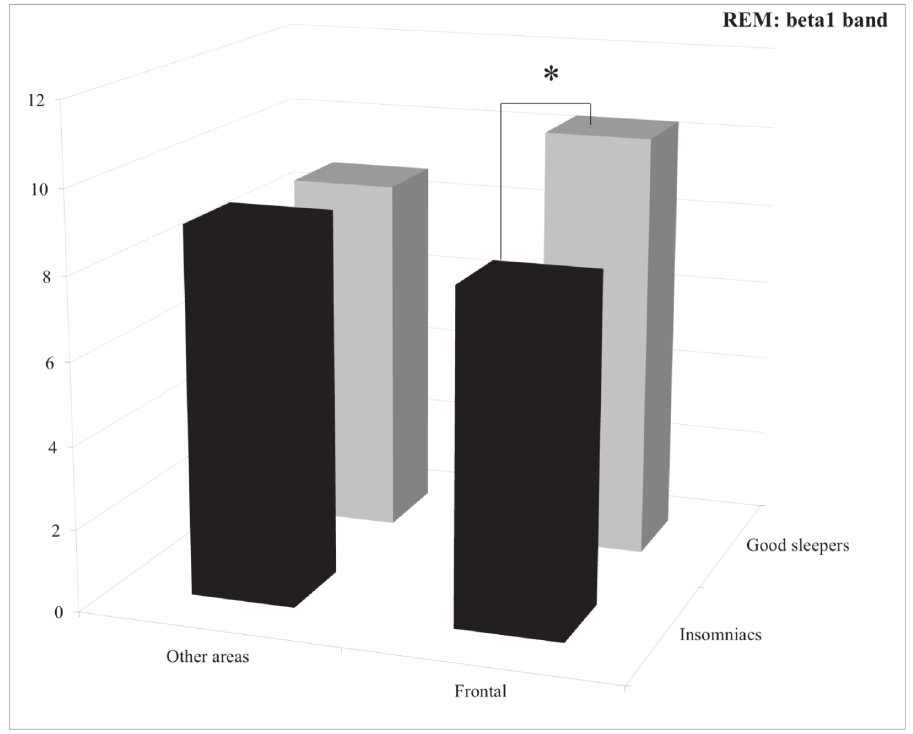
Figure 6. Relative power spectra for the beta1 band during stage REM for both groups (insomnia patients and good sleepers) and each areas (others vs prefrontal). * 0.1 > p > 0.05.